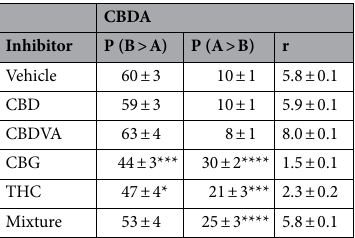
Table 3. BCRP permeabilities of CBDA in the presence of cannabinoids. P Permeability calculations (× 10 −5 cm/s). * p < 0.05, *** p < 0.0005, **** p < 0.0001 compared to vehicle.